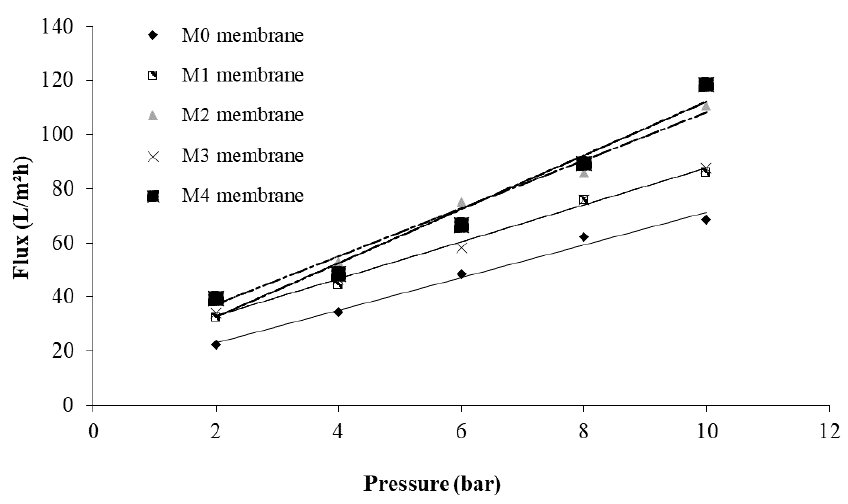
Figure 9. Water flux versus applied pressure for membrane (M0) and composite membranes (M1–M4). Table 3. HPLC-MS analysis results for ASE extract and retentate